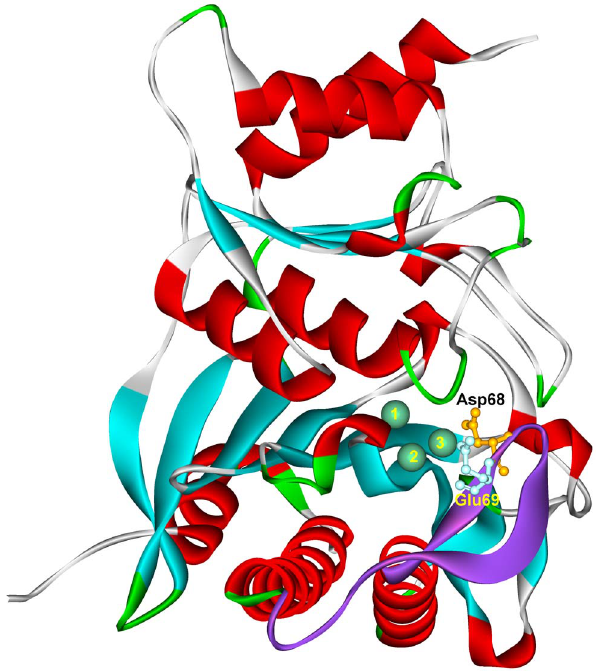
Figure 3. Effect of calcium on the association of the wild-type and Tyr 57 Trp mutant of human muscle FBPase with sarcomeric Z-line. In control conditions, TRITC-labeled WT FBPase (red) and FITC- labeled Tyr 57 Trp mutant (green) accumulates on the sarcomeric Z-lines. In the presence of 10 m M Ca 2 + , WT FBPase dissociated from the Z-line but the Tyr 57 Trp mutant remained bound to the sarcomeric structures. 200 m M Ca 2 + disrupted interactions of both the proteins with Z-line.